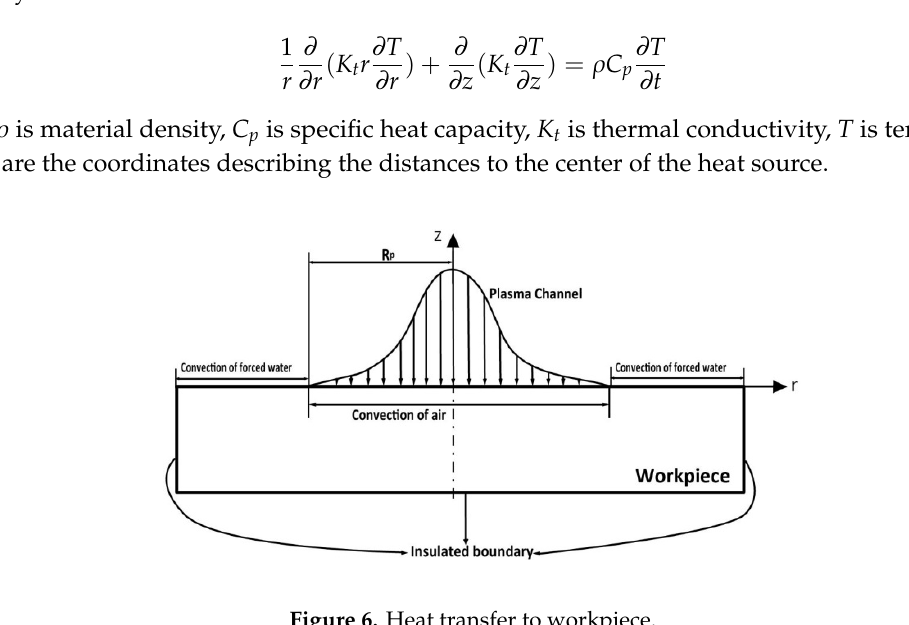
Figure 6. Heat transfer to workpiece.